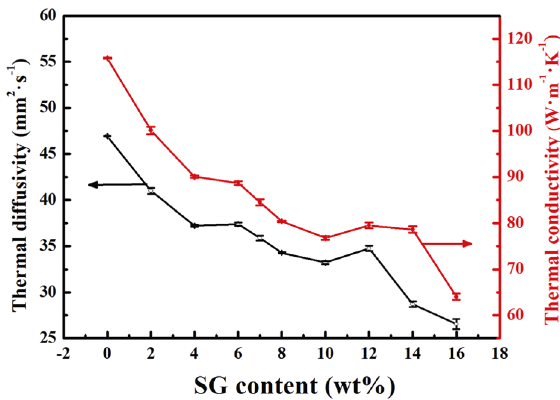
Fig. 11 Thermal diffusivity α and thermal conductivity λ of SG/AlN composites with different SG